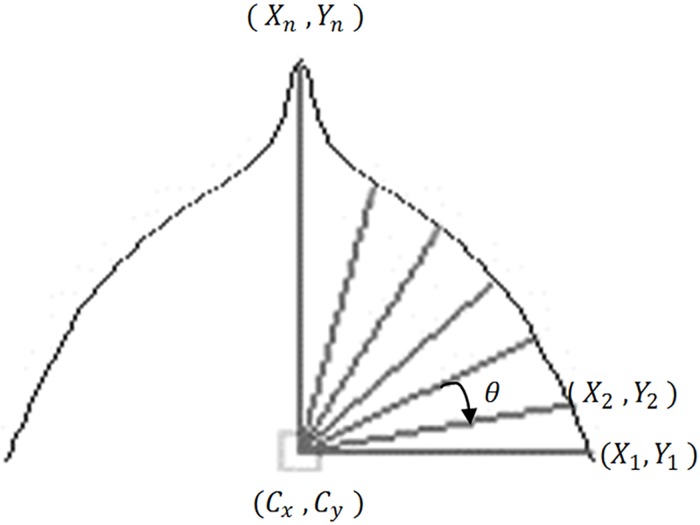
Centroid Contour Gradient approach.